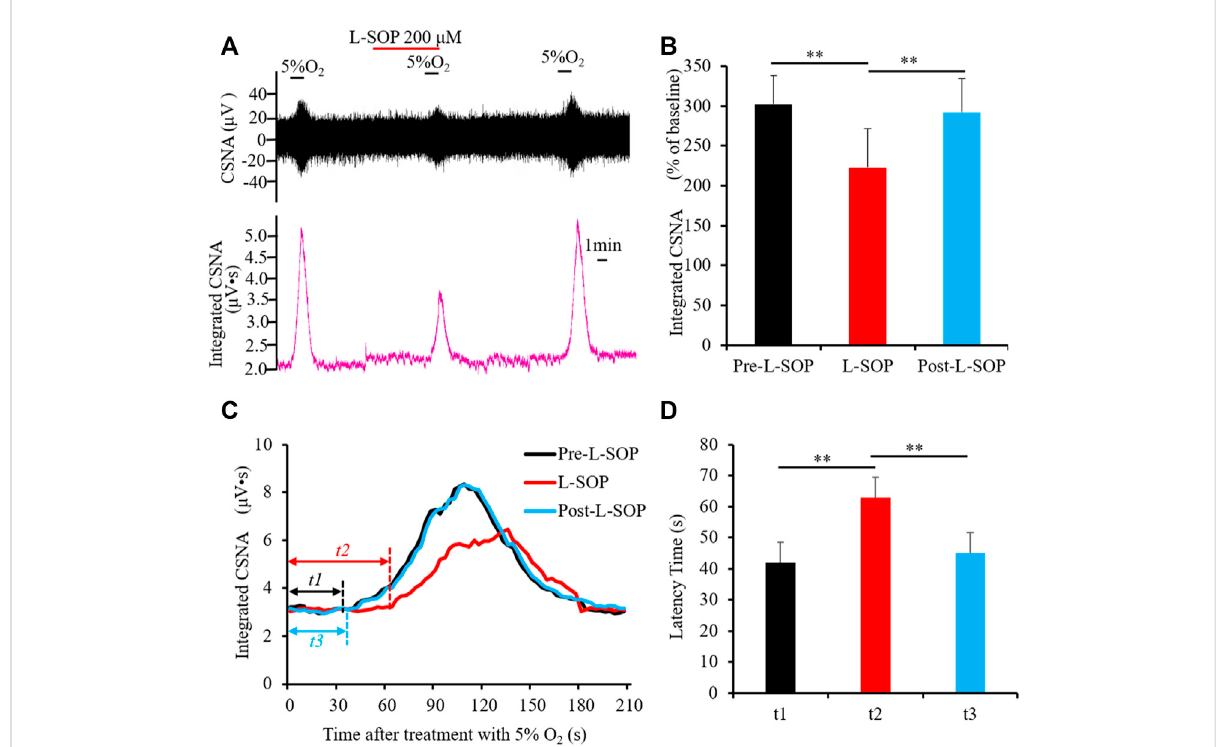
FIGURE 5 L-SOP attenuates CB response to hypoxia. (A,B) L-SOP (200 µM) inhibited hypoxia-evoked CSN discharge. (A) Shows the representative recordings of CSN discharge and integrated CNSA before, after, and post treatment of L-SOP (Pre- L-SOP, L-SOP and Post- L-SOP); (B) reveals the dataanalysisofhypoxia-evoked integrated CSNA,represented asthepercentageofbaseline. (C,D) L-SOP extendedtheduration ofhypoxia-evoked CSN fi ring. t represents the latency time that is referred to as the time from superfusion hypoxia solution to the onset of CSN sharply fi ring. t1 : LatencytimeofCBresponseto hypoxiabeforetreatmentwithL-SOP (Pre-L-SOP); t2 :LatencytimeofCBresponseto hypoxiawhile treatment with 200 μ M L-SOP (L-SOP); t3 : Latency time of CB response to hypoxia after wash out with L-SOP (Post- L-SOP). (C) Shows the representative recordings of integrated CNSA in the condition of Pre- L-SOP, L-SOP, and Post- L-SOP; (D) reveals the data analysis of the latency times of CB response to hypoxia in the condition of Pre- L-SOP, L-SOP, and Post- L-SOP. L-SOP: Group III mGluRs agonist; CSNA: carotid sinus nerve activity. The data were presented as mean ± SEM. n = 6, ** p < 0.01 indicate signi fi cant difference (One-Way ANOVA with repeated